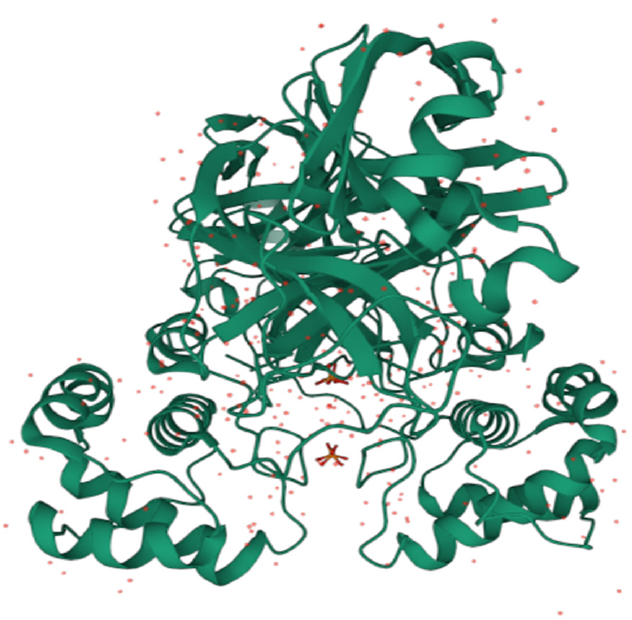
Figure 9. Crystal structure of SARS 3CL protease 7JSU.